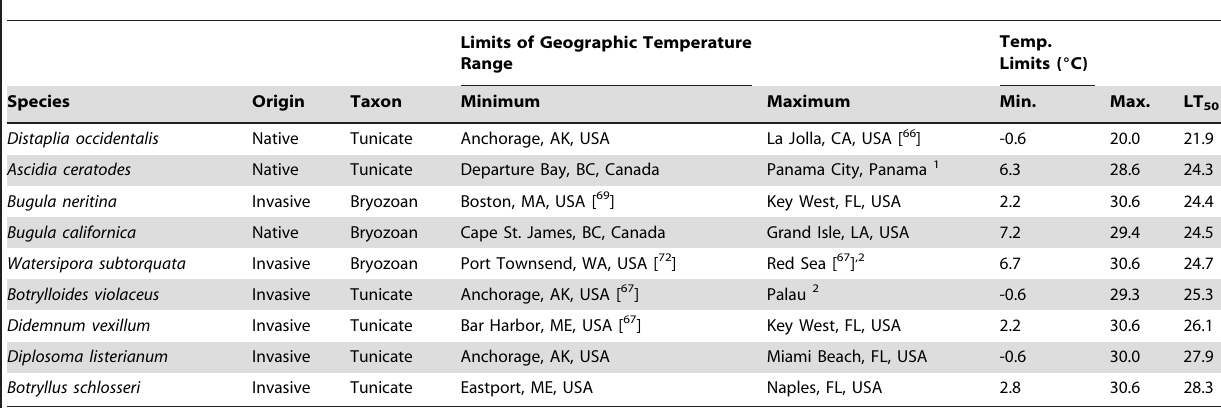
Table 1. Geographic temperature limits and lethal temperatures (LT 50 ) for the 9 study